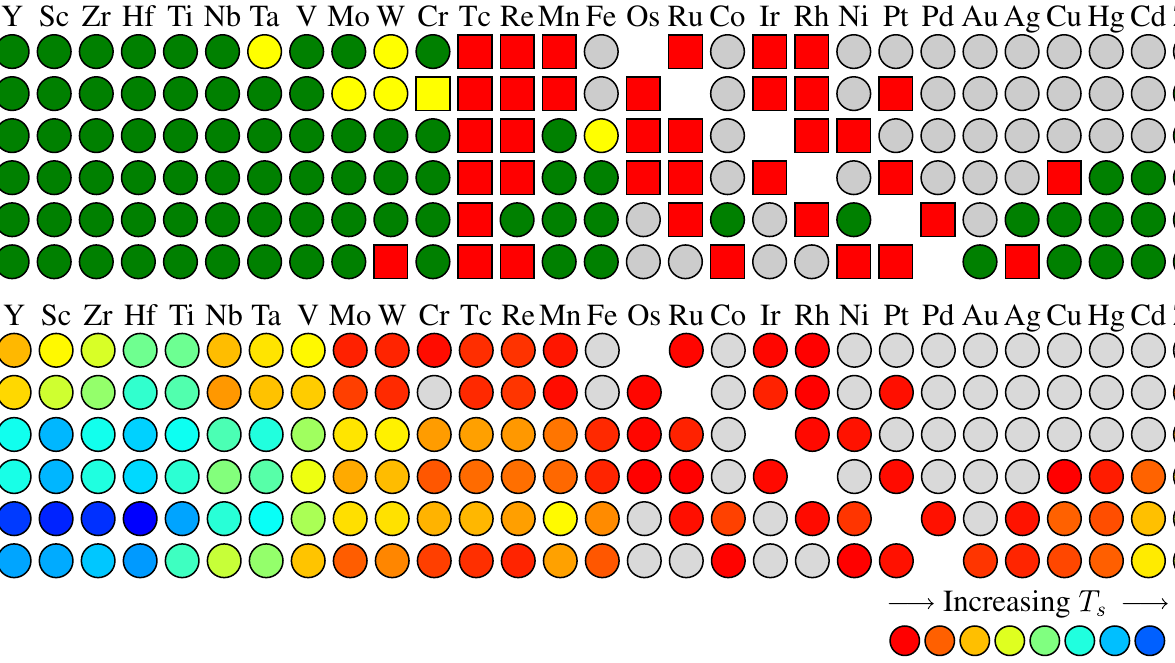
FIG. 1. Top panel: Compound-forming vs non-compound-forming systems as determined by experiment and computation. Circles indicate agreement between experiment and computation—green for compound-forming systems, gray for non-compound-forming systems. Yellow circles indicate systems reported in experiment to have disordered phases, for which low-energy compounds were found in this work. Ru-Cr is the only system (yellow square) experimentally reported to include a disordered phase where no low- temperature stable compounds were found. Red squares mark systems for which low-temperature compounds are found in computation but no compounds are reported in experiment. Bottom panel: T s for the binary systems in this work. Colors: From red to blue indicates the lowest to highest T s